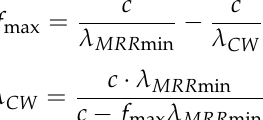
Figure 9. ( a ) Modeled wavelength dependence of the photodiode responsivity; ( b ) Modeled dependence of the relative power at the system output on the analyte RI in the scheme with a broadband source.